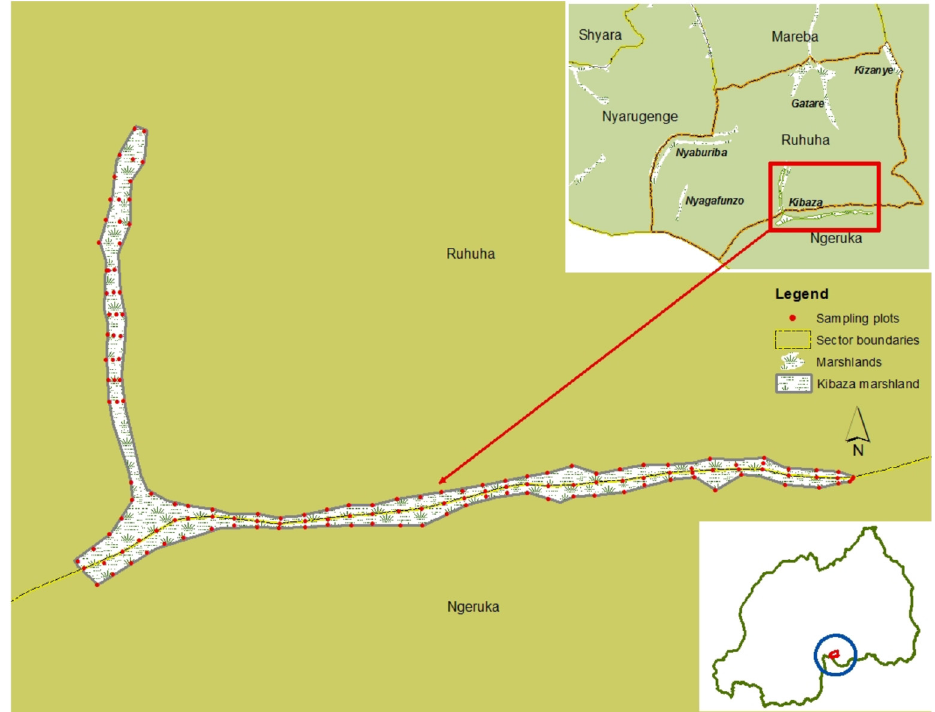
Figure 2. Example of sampling sites for mosquito larval stages in the Kibaza rice field-1 (ES1), Ruhuha, Rwanda.